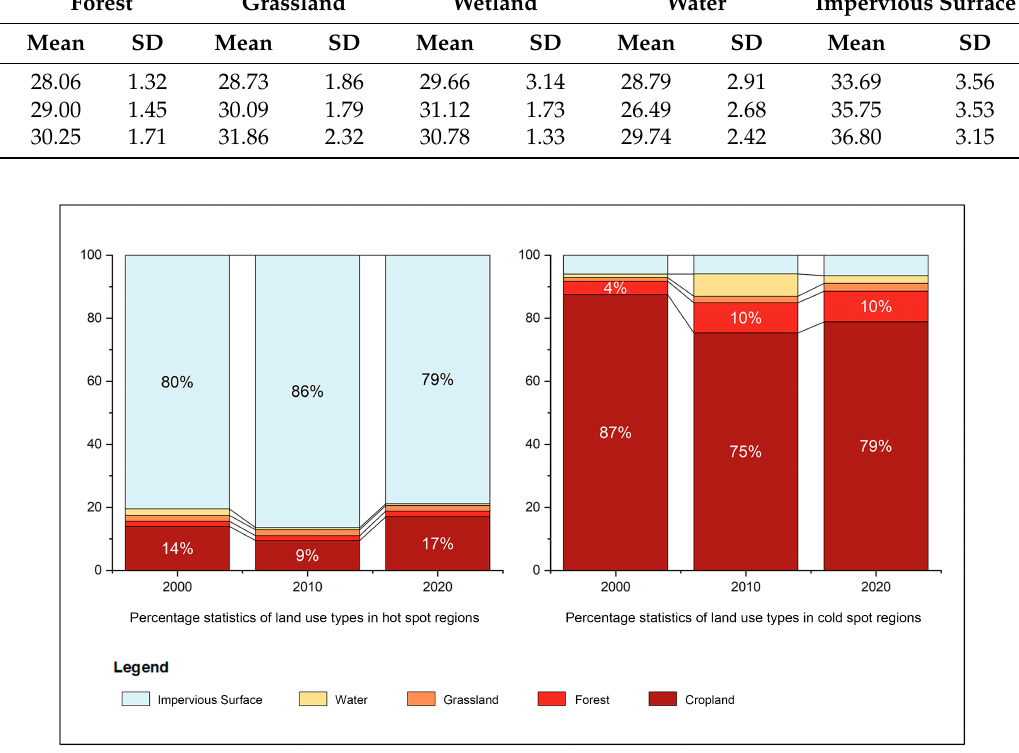
Figure 8. Statistics on the percentage of land use types in hot and cold spot regions.